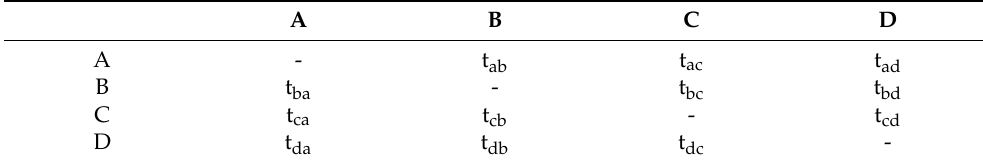
Table 1. Confidence Criterion Matrix [18].